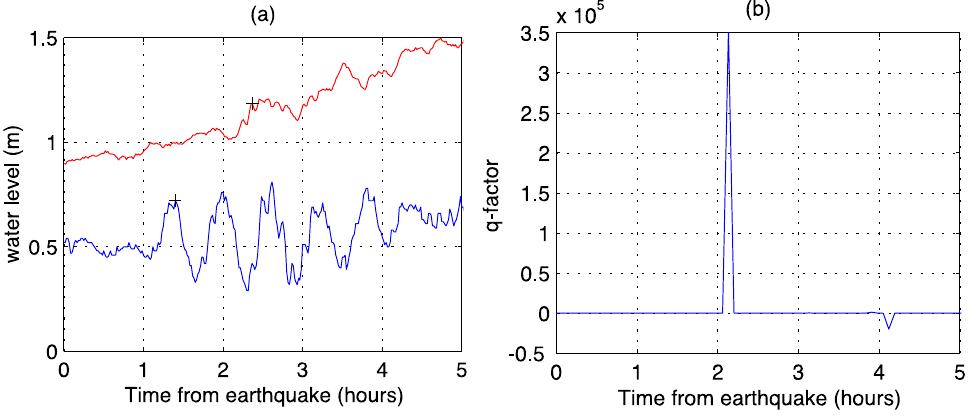
Figure 4. Tide gauge and q-factor observations 11 April 2012. ( a ) Tide gauge water levels. Blue: Sinabang, Red: Teluk Bayur (water levels are offset by − 2 m to help with the plotting). The arrival of the first tsunami is indicated by ‘+’. ( b ) The q-factor from the PDNG